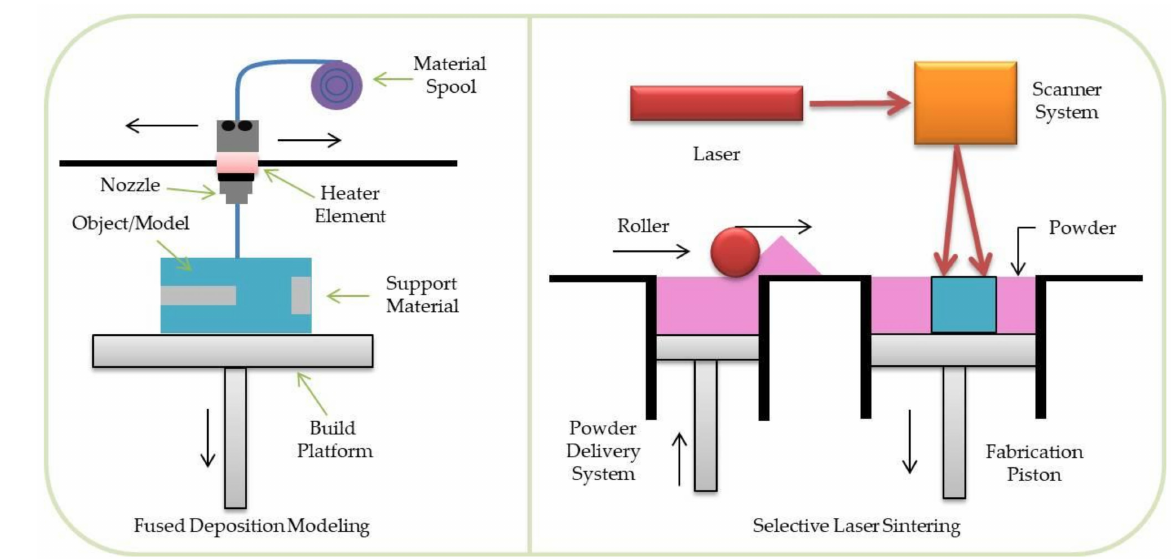
Figure 7. Scheme illustration of FDM (left) and SLS (right)